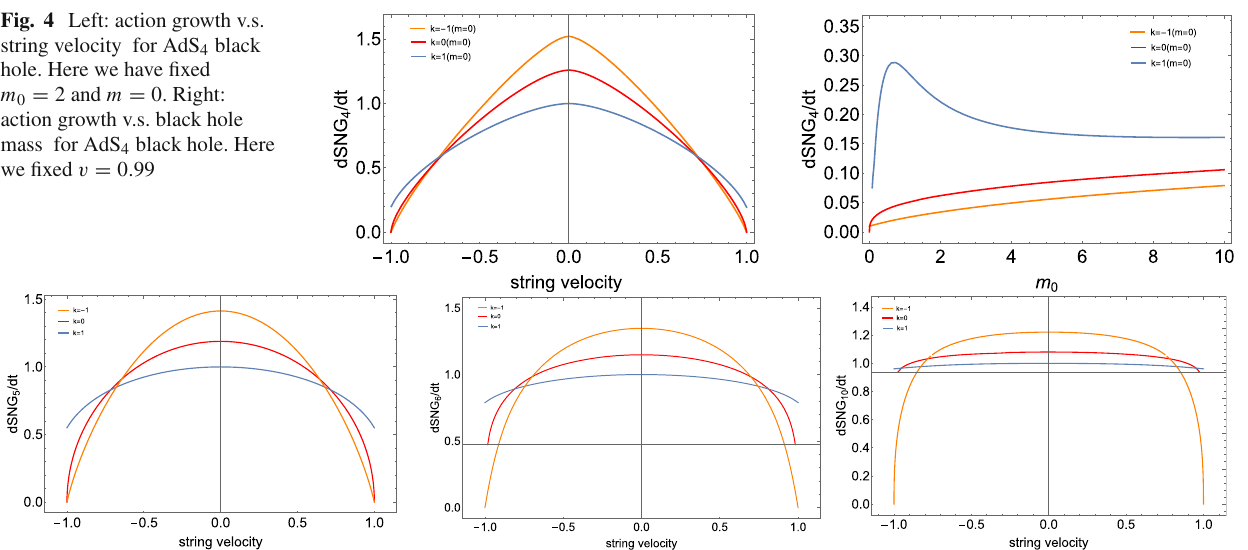
Fig. 4 Left: action growth v.s. string velocity for AdS 4 black hole. Here we have fixed m 0 = 2 and m = 0. Right: action growth v.s. black hole mass for AdS 4 black hole. Here we fixed v = 0 . 99